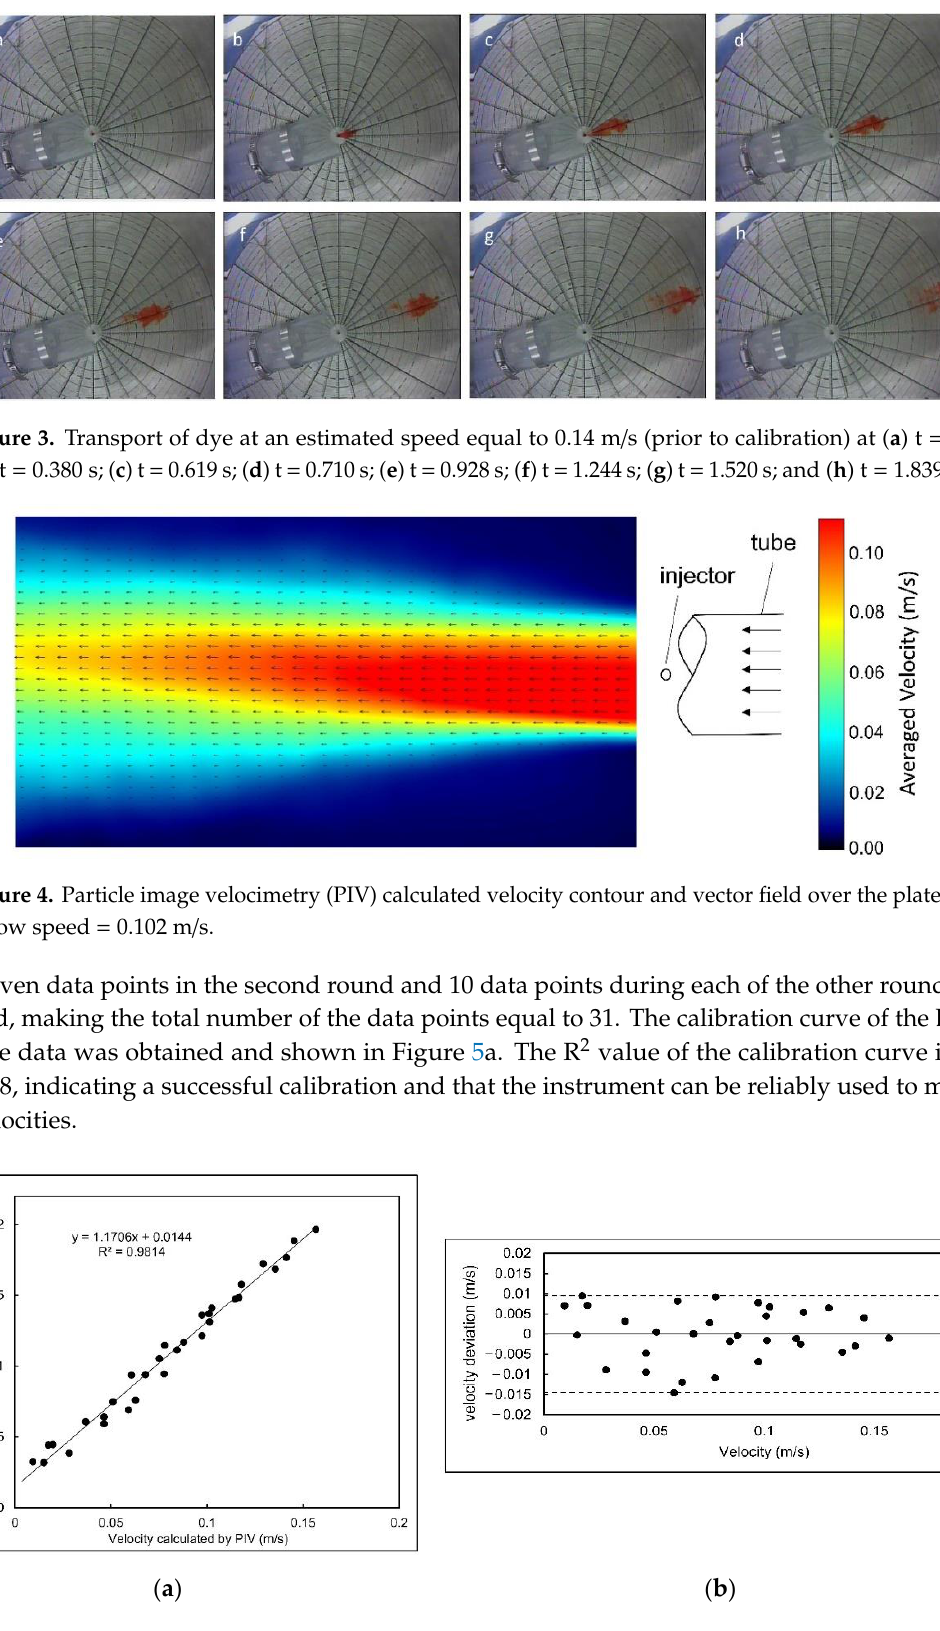
Figure 6. Actual distance travelled by the dye vs. the DIV camera estimation. 3.2. Uncertainty Analysis There is some uncertainty associated with the recorded video of the DIV and how this uncertainty propagates to a final estimate of velocity can be calculated using error analysis. The distance that the dye traveled and the associated travel time were found by analyzing the video. The recorded video had a resolution of 720 × 288 pixels and 50 fps of frame rate. That corresponds to 0.5 mm and 0.02 sec of distance and time uncertainty, respectively. These uncertainties propagate to the final estimate of velocity and this propagation is computed below. Velocity was calculated using Equation (2). The uncertainty in velocity due to the propagation of distance and time uncertainties can be calculated by Equation (3).